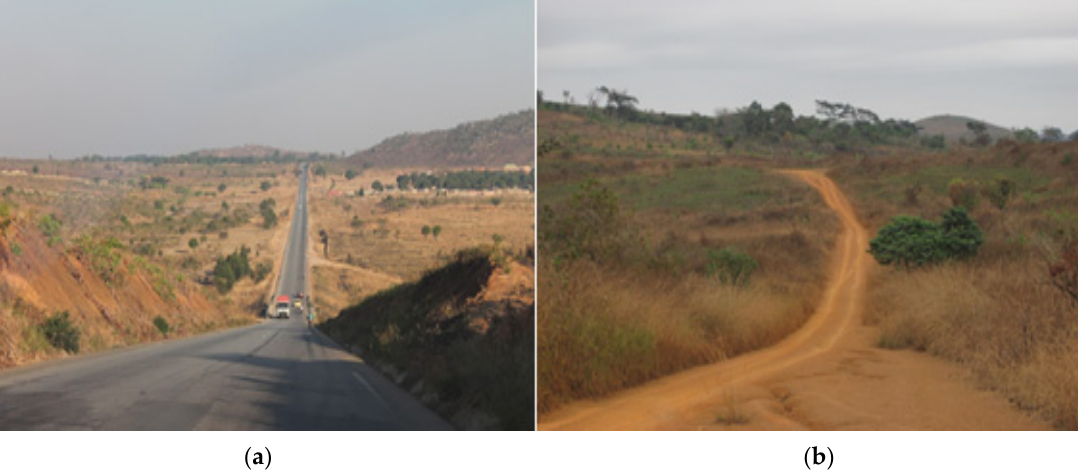
Figure 2. Types of roads in Angola: ( a ) primary roads and ( b ) tertiary roads are usually passable in the dry